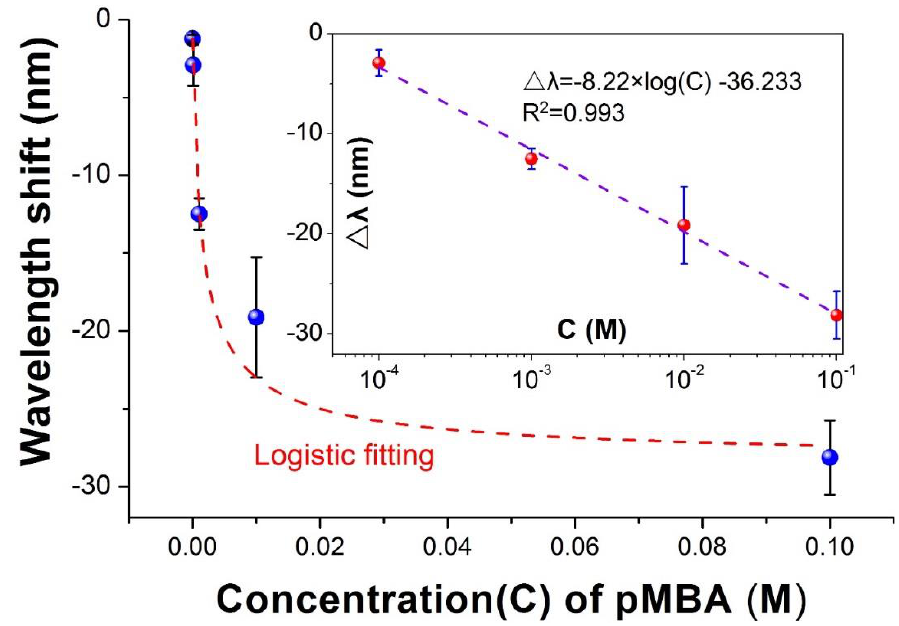
Figure 4. Response curve of sensing p MBA solutions with different concentrations using VIOLIN chemical sensor. Inset: the log-linear correlation at part region of the concentrations.